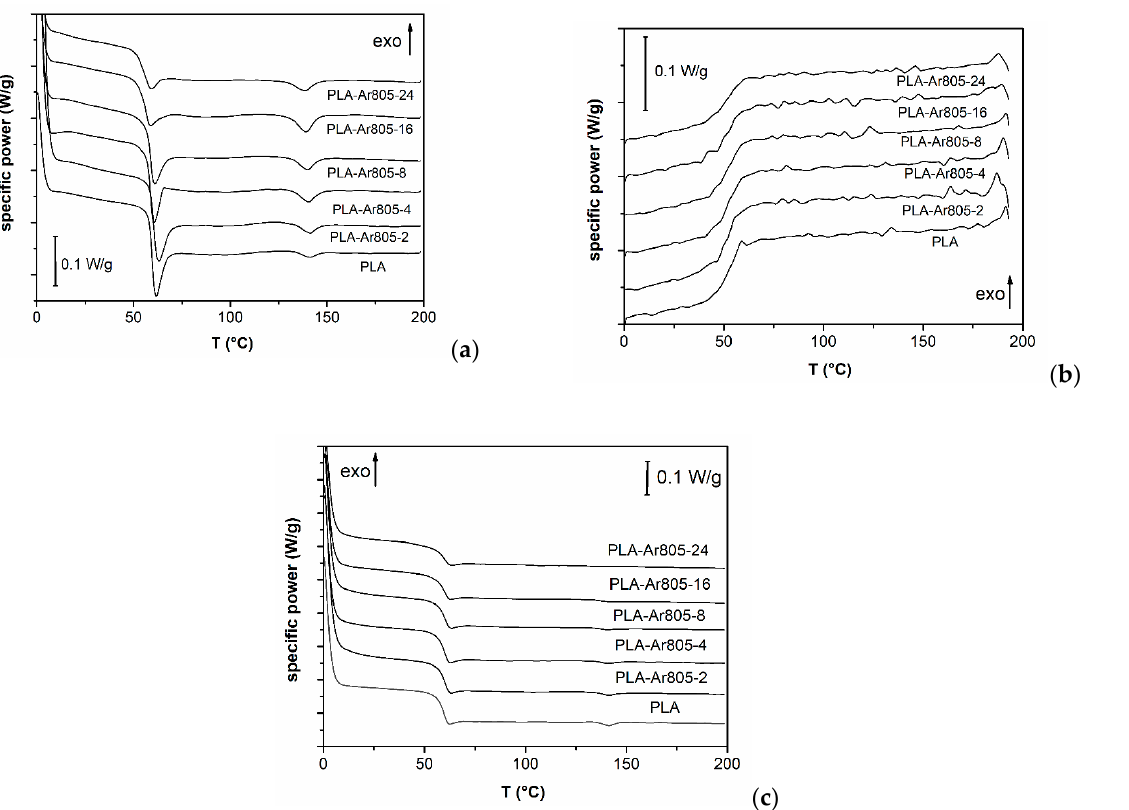
Figure 3. Differential scanning calorimetry (DSC) thermograms of neat PLA and relative nanocomposites at different nanosilica contents (2–24 vol%). ( a ) First heating; ( b ) cooling step; ( c ) second heating. Table 3. Results of DSC analysis of neat PLA and relative nanocomposites at different nanosilica contents (1–24 vol%).